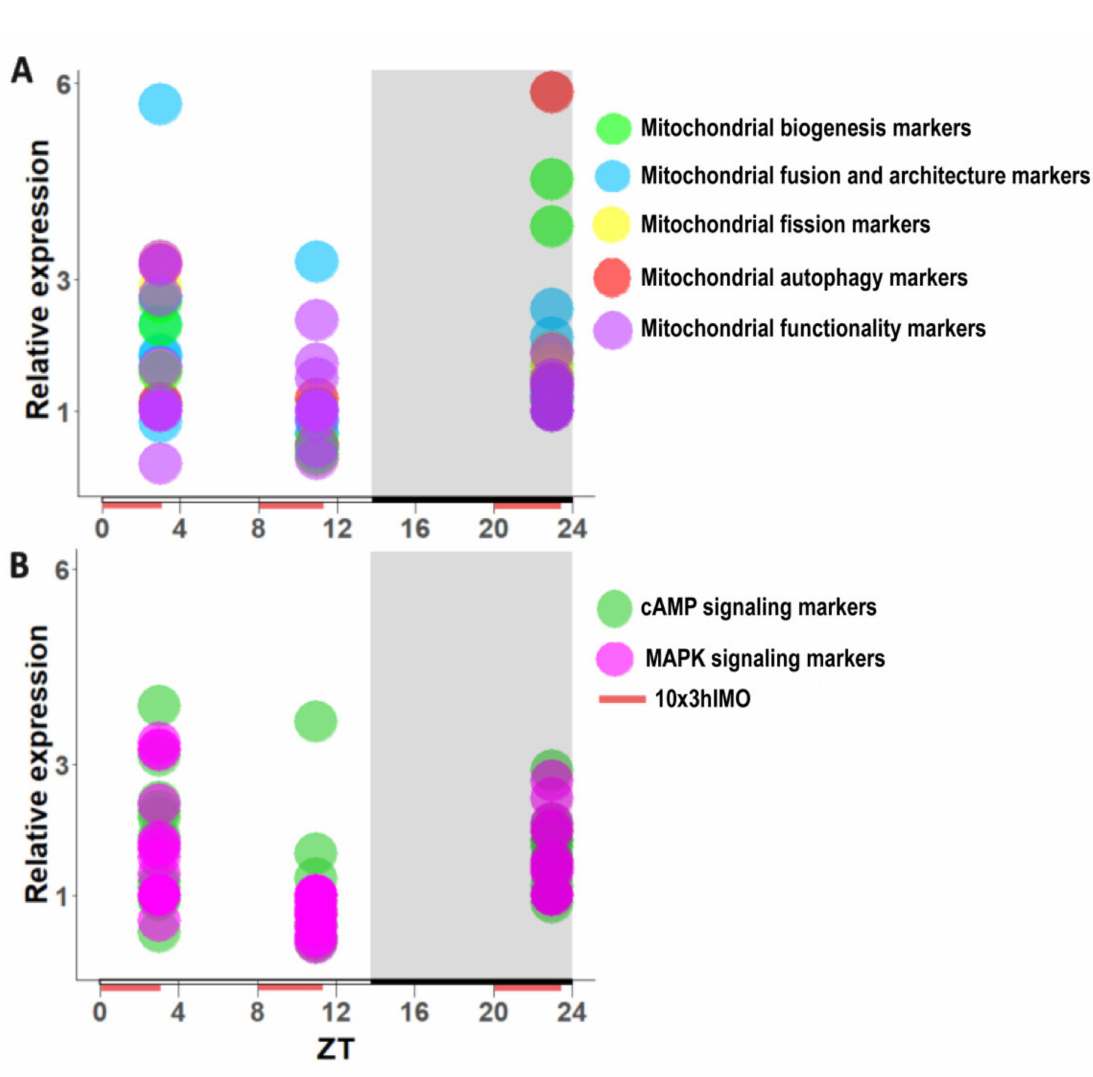
Figure 11. Pattern of transcripts from spermatozoa obtained from repeatedly stressed rats at different ZT time points (ZT3, ZT11, and ZT23) during the day (24 h). Data show transcriptional pattern of genes encoding the proteins are important for mitochondrial dynamics/functionality ( A ) as well as cAMP and MAPK signaling pathways ( B ). Points represent a deviation in the transcription of a particular gene at different ZT time